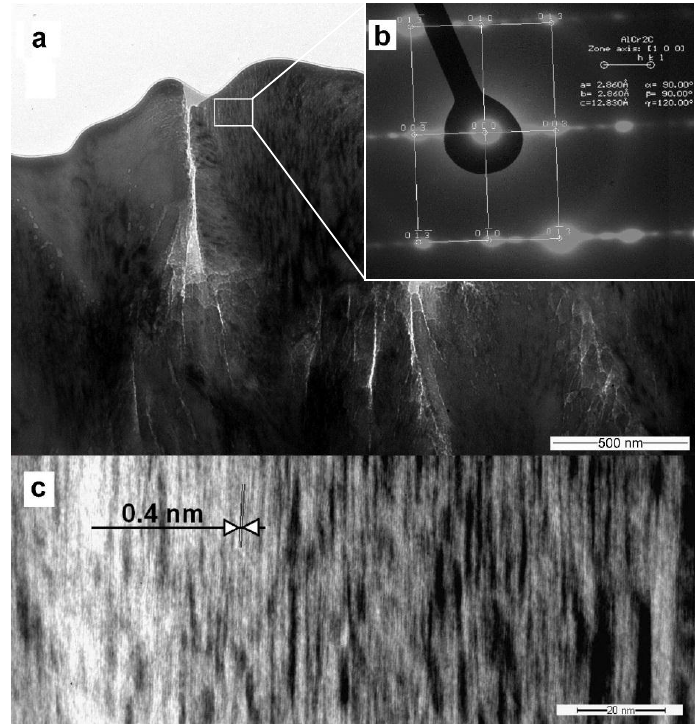
Figure 6. ( a ) Bright-field image and ( b ) the corresponding calculated SAED pattern and ( c ) magnification showing (003) lattice image of the Cr 2 AlC coating deposited at 2.5 kW sputtering power.